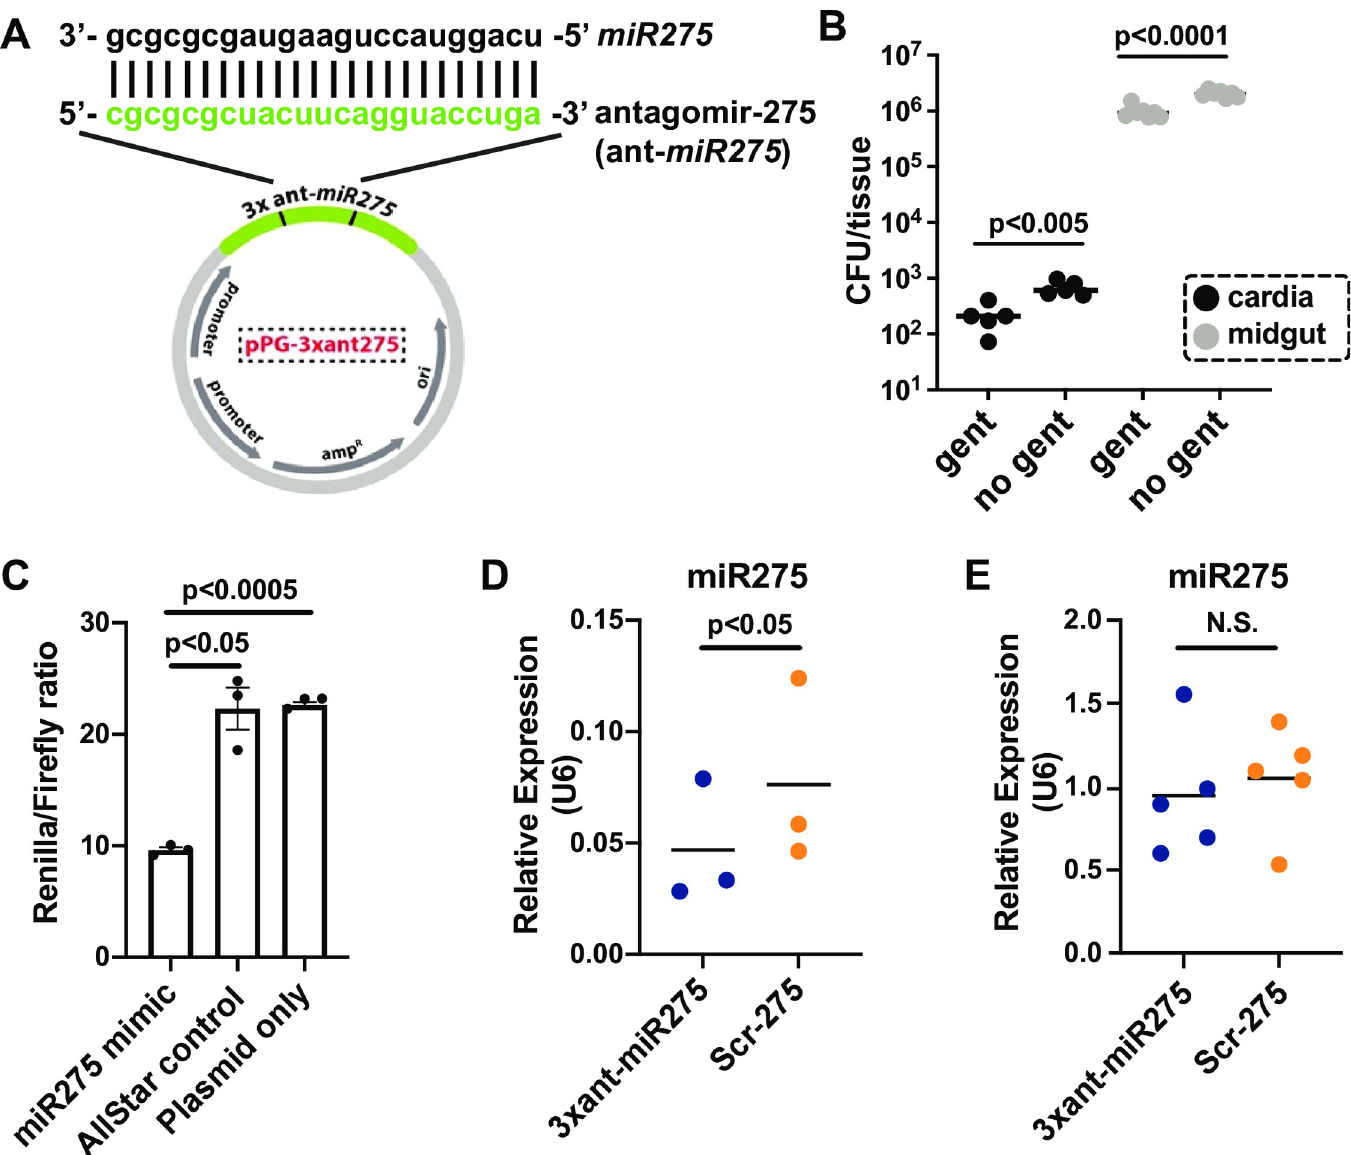
Fig 1. The successful development of paratransgenic expression system. (A) rec Sodalis plasmid construct. Three tandem antagomir-275 repeats (3xant- miR275 , in green) that are complementary to the tsetse miR275 mature sequence were cloned into plasmid pgRNA. Each repeat is separated by a 3-nucleotide linker sequence. 3xant- miR275 , and a similarly engineered construct that encodes a scrambled antagomir-275 (Scr- 275 ), were electroporated into Sodalis WT to generate strains designated Sgm 3xant- miR275 and Sgm Scr-275 , respectively. (B) Quantification of Sgm 3xant- miR275 within cells of tsetse’s cardia (black) and midgut (grey) via gentamicin exclusion assay. Each dot represents one tsetse organ ( n = 5). A Student’s t-test was used to determine statistical significance. (C) Dual luciferase reporter assay. Each dot represents the average of normalized luciferase signal ( Renilla / Firefly ratio) ± SEM of each experiment. The 3xant- miR275 construct was cloned into the psiCheck-2 plasmid containing two luciferase reporter genes, Renilla (reporter) and Firefly (internal control). The luciferase activity is measured by the Renilla signal normalized to the Firefly signal. Three different experiments were performed to test the binding efficacy between 3xant- miR275 and 1) synthetic miR275 mimic, 2) synthetic AllStars Negative Control, and 3) psiCheck plasmid without adding any miRNA. Three biological replicates (with 3 technical replicates each) per experiment were used. Bonferroni’s multiple comparison tests were used to determine statistical significance. (D) miR275 expression level in the midgut of paratransgenic Gmm 3xant- miR275 versus Gmm Scr-275 flies. Each dot represents 5 individual midguts. A student’s t-test was used to determine statistical significance. (E) miR275 expression in the cardia of Gmm 3xant- miR275 versus Gmm Scr-275 flies. Each dot represents 5 individual cardia. A student’s t-test was used for statistical analysis.